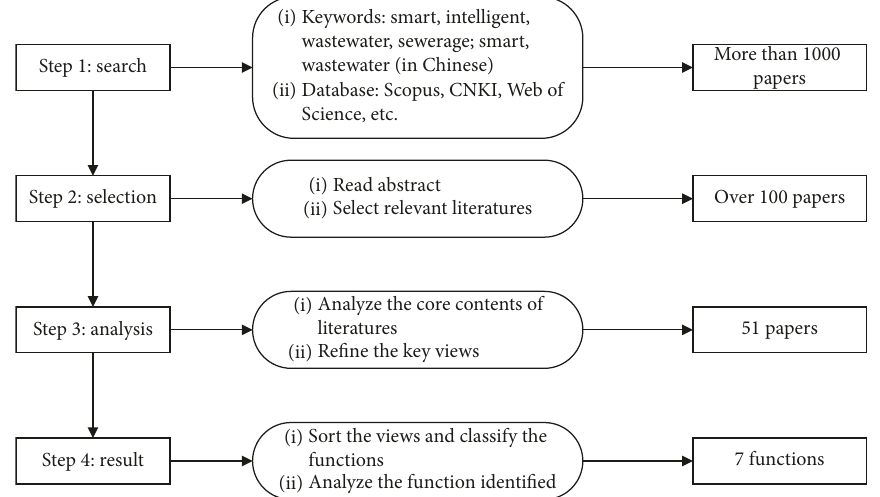
Figure 2: Process of systematic literature